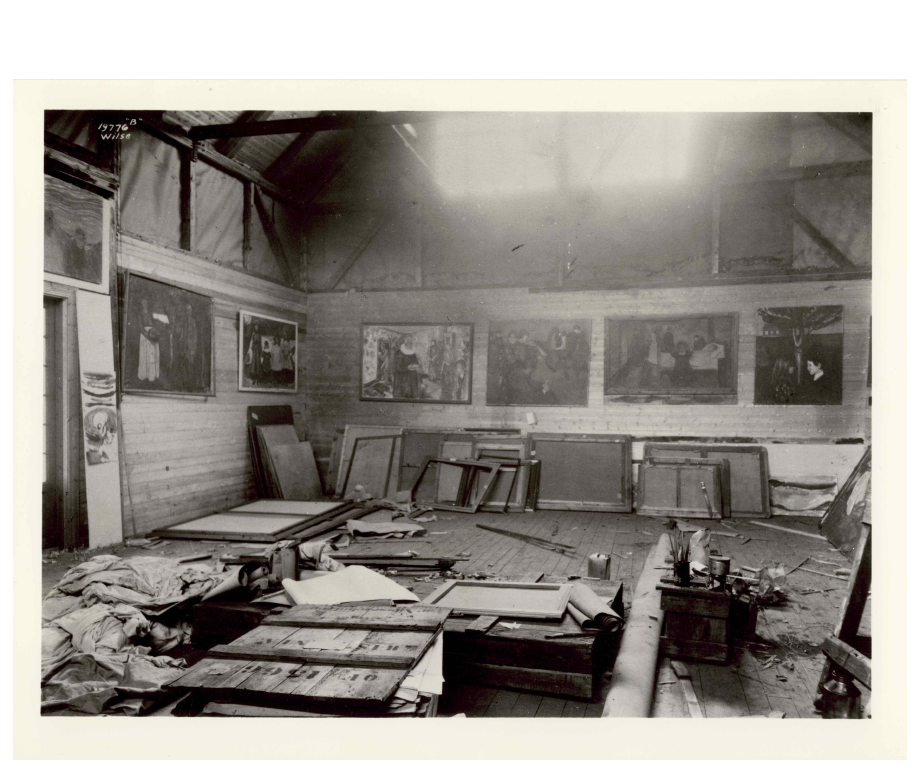
Figure 1: Munch’s studio at Ekely. MM.B.02853 Photo: Anders B. Wilse © Norsk